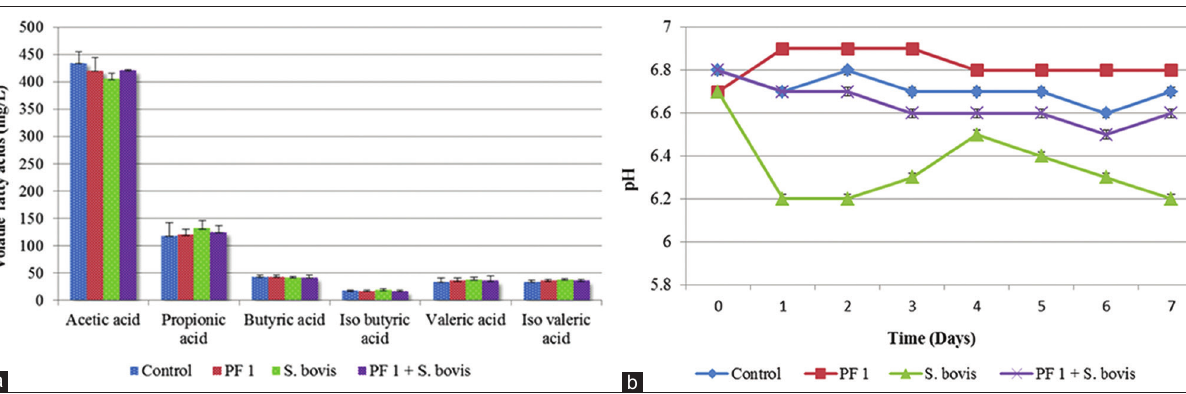
Figure-4: Fermentation profile of in vitro rumen simulation technique studies including (a) volatile fatty acid profile and (b) pH profile of control, probiotic formulation (PF) 1, Streptococcus bovis and PF 1+ S. bovis from day 1 to day